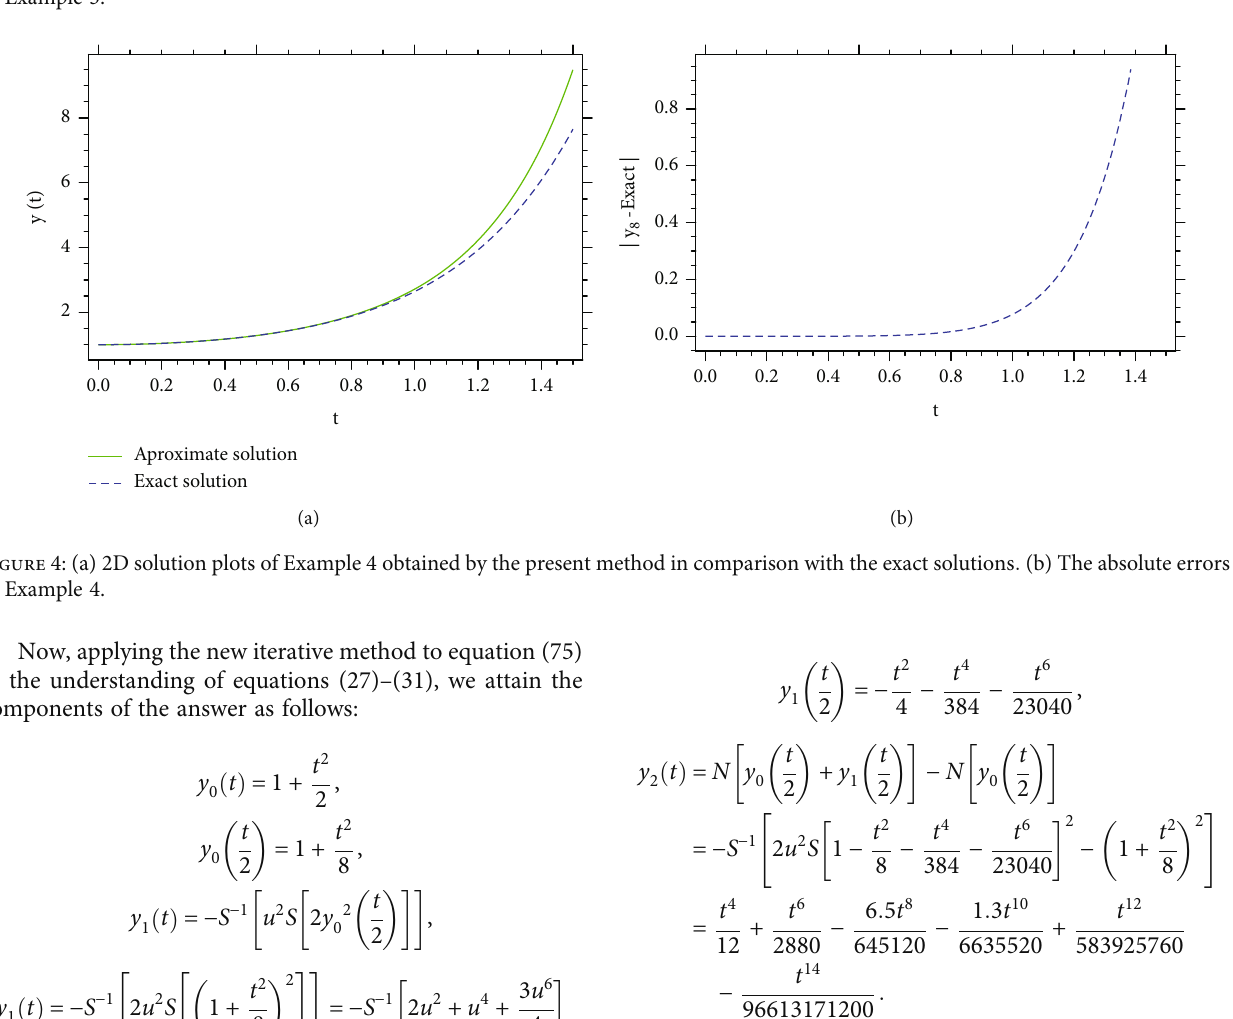
Figure 3: (a) 2D solution plots of Example 3 obtained by the present method in comparison with the exact solutions : (b) The absolute errors of Example